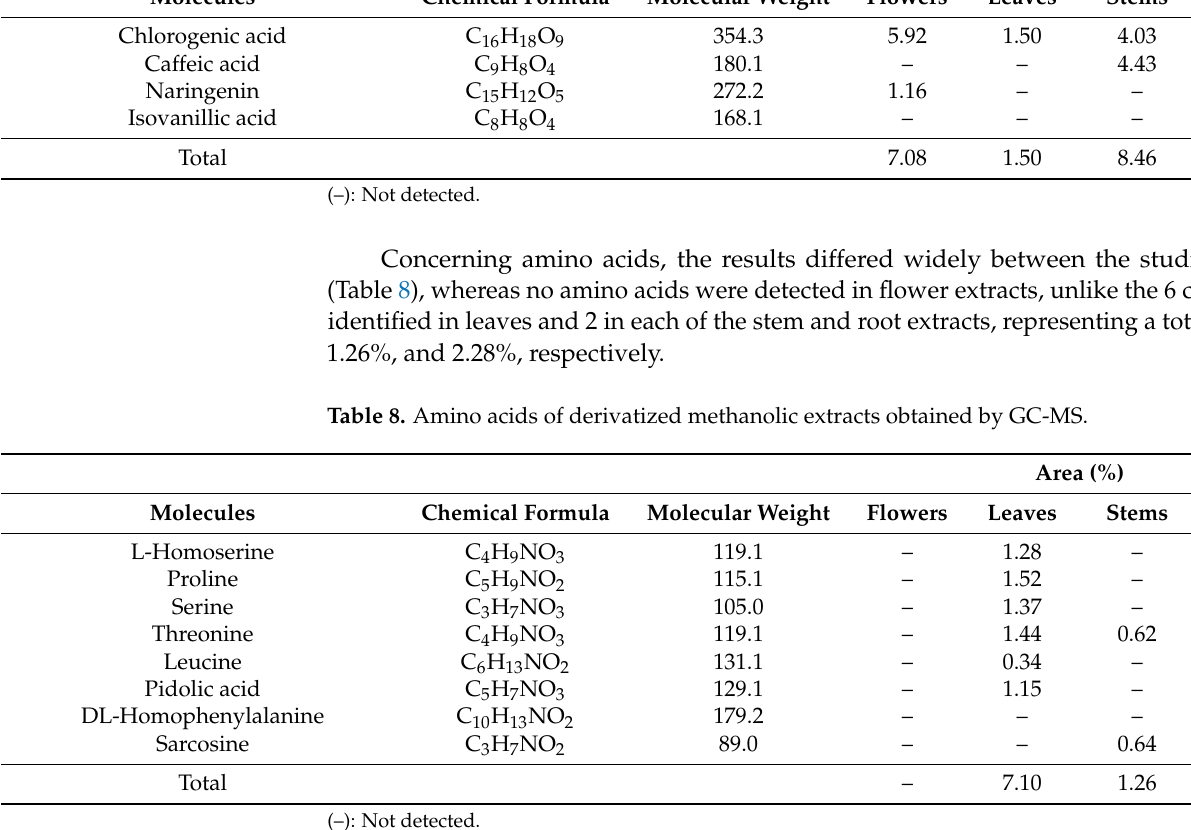
Table 7. Phenolics of derivatized methanolic extracts obtained by GC-MS.